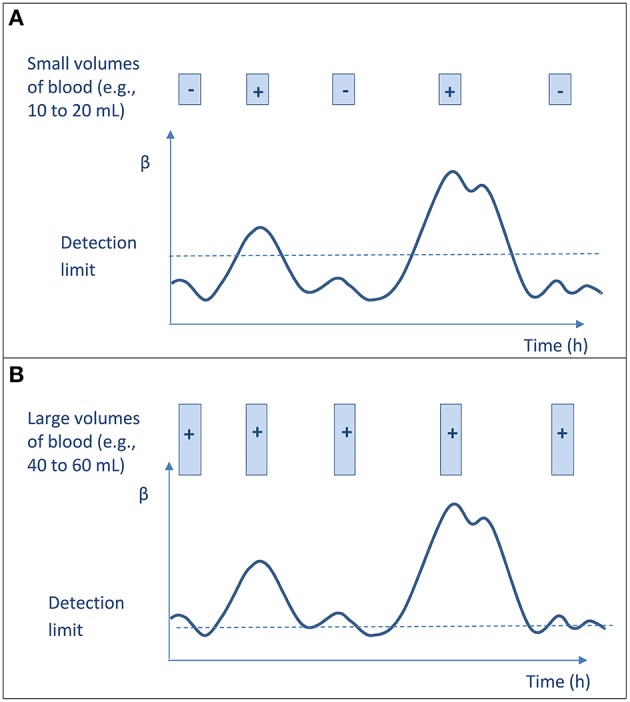
Blood culture result (negative or positive) according to the amount of blood cultured at each sampling and to the microbial burden in blood. The curve represents the bacterial concentration (β) in blood that varies with time and may be very low, but never null. The limit of bacteremia detection (BC sensitivity) is indicated with dotted line. Each sample is represented by a box. (A) Culturing low volumes of blood does not ensure sensitive testing and low detection threshold, and thus leads to uncertain bacteremia detection according to time of collection. The overall results suggest an intermittent bacteremia. (B) Culturing large volumes of blood ensures low detection threshold, thus allowing detecting bacteremia whenever the sample is obtained. One sample is enough for confidently detecting bacteremia; the overall results would suggest a continuous bacteremia.